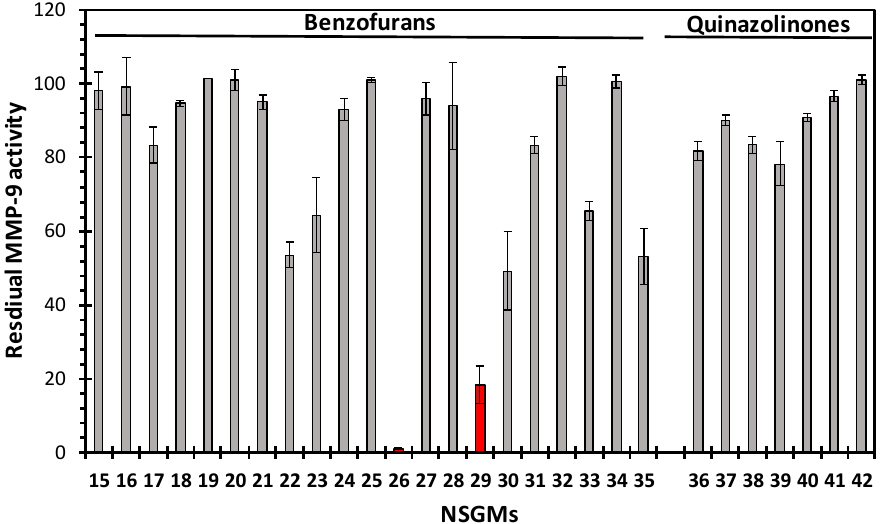
Figure 6. Screening of NSGM 15 – 42 at 100 µM against MMP-9. Experiments were performed using a commercially available assay kit (Abcam, Cambridge, U.K.) in at least duplicates. Error bars represent ± 1 SD.